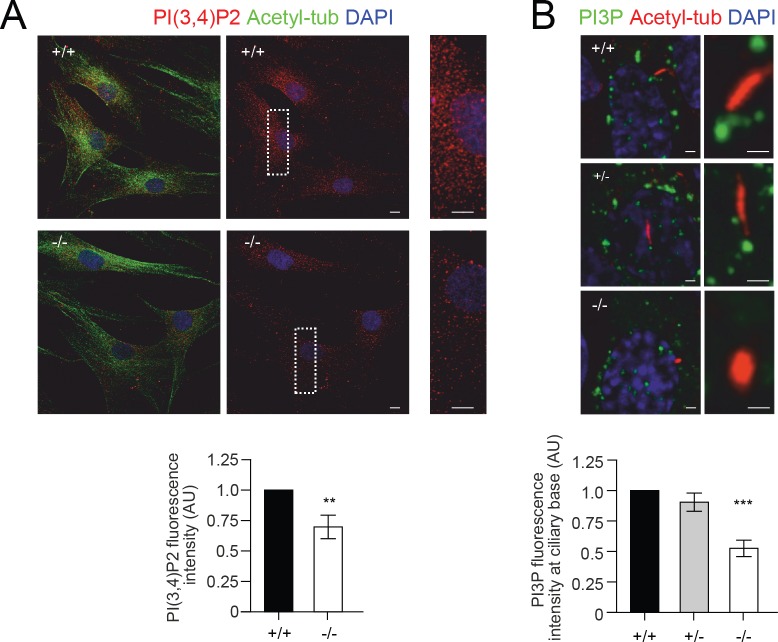
Impaired PI metabolism in patient-derived fibroblasts.Quantification of PI(3,4)P2 and PI(3)P were analysed and normalized on whole cell fluorescence. (A) Immunofluorescence analysis of cellular PI(3,4)P2 levels. Results showed that PI(3,4)P2 is significantly reduced throughout the cell in -/- cells compared with +/+ cells. n = 4 independent experiments and 10 cells per genotype for each experiment (S6 Table). (B) Immunofluorescence analysis of PI(3)P localization at the base of the primary cilium. Results showed that PI(3)P is significantly reduced at the base of the primary cilium in -/- cells compared with +/+ and or +/- cells. n = 3 independent experiments and 15 cells per genotype for each experiment (S6 Table). Nuclei are stained with DAPI. ** indicates p < 0.01. *** indicates p < 0.0001.